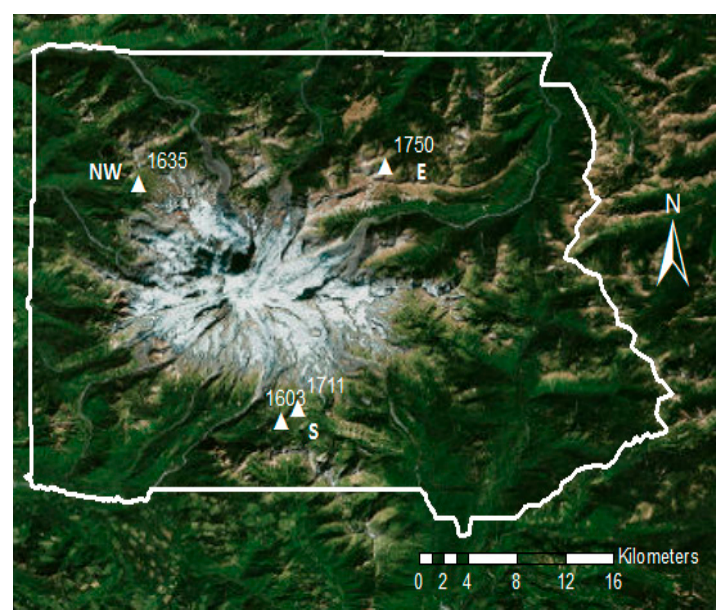
Figure 1. Tree core collection locations in Mt. Rainier National Park, Washington. The labels denote elevation in meters. White line shows the border of Mt. Rainier National Park.